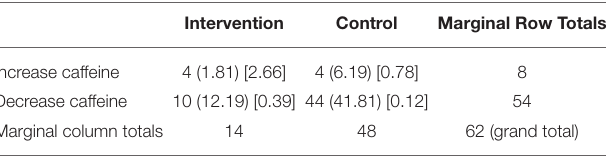
Table information is provided as follows: observed cell totals (expected cell totals) [chi-square statistic for each